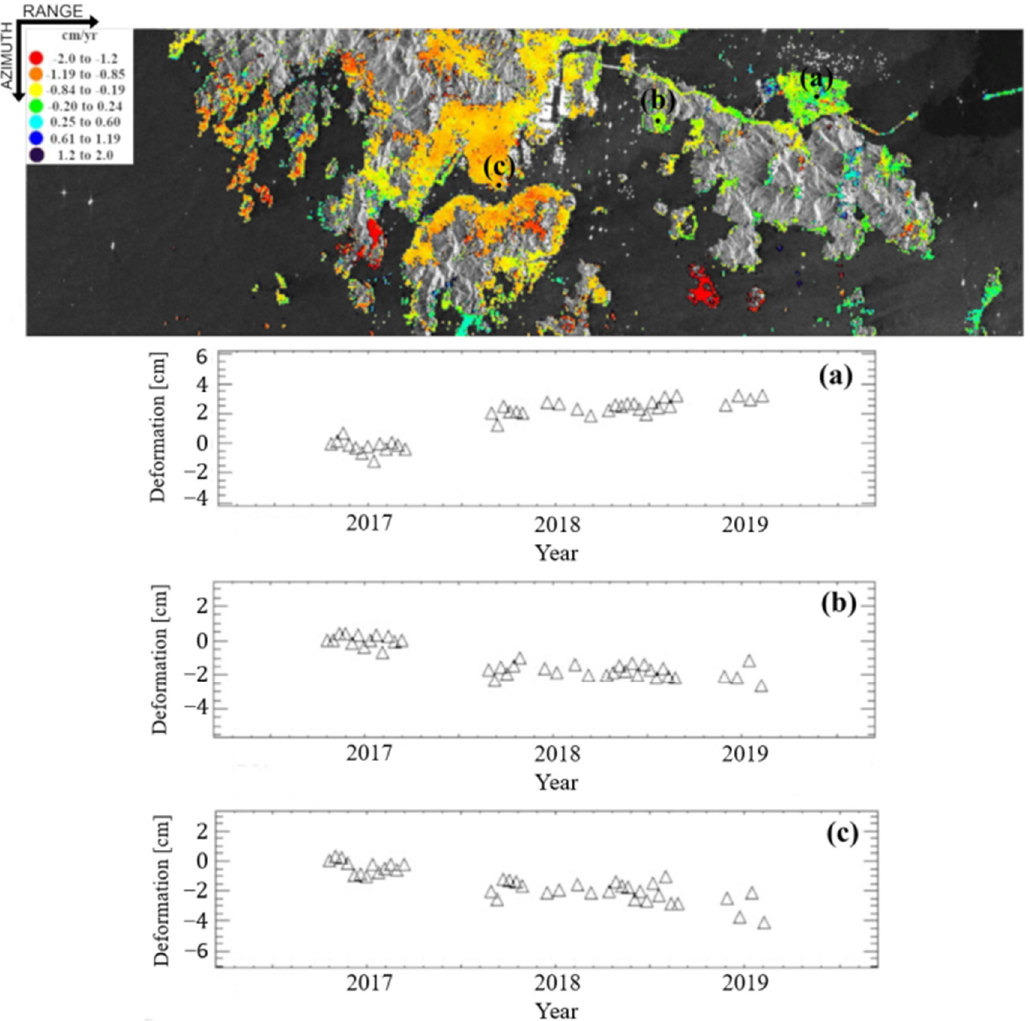
Figure 10. Hong Kong deformation time series: ( a ) HK airport, ( b ) HK Disneyland, and ( c ) HK city coastal area. Note that map is shown in radar coordinates.